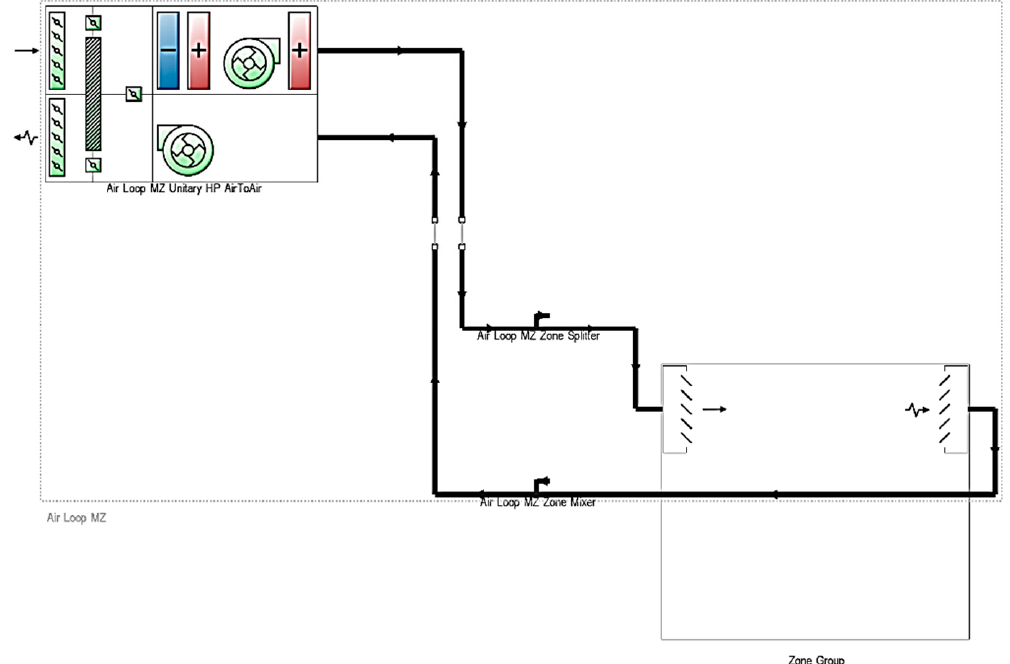
Figure 2. The unitary air-to-air heat pump with an electric supplementary heating coil and a heat recovery component.